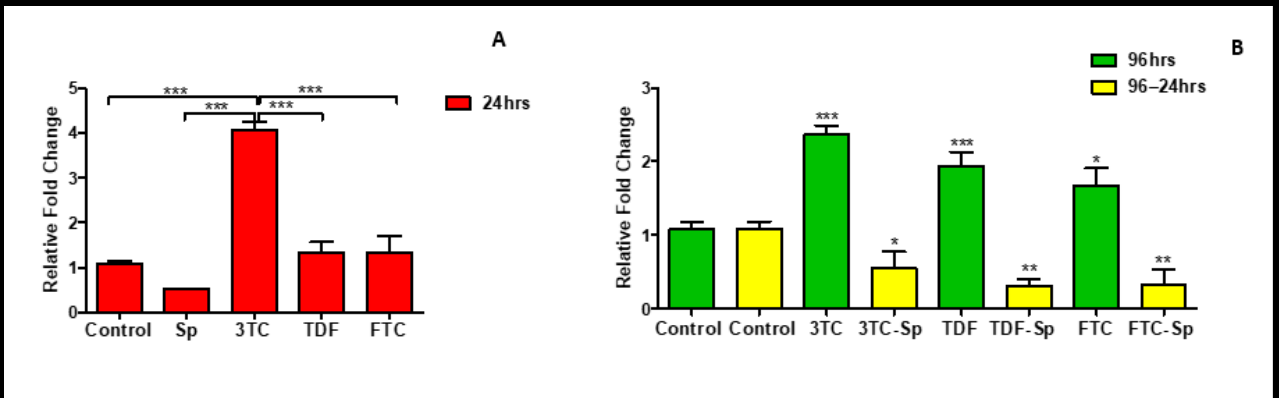
Figure 2. Effects of SP and HAART (3TC, TDF, and FTC) on eNOS mRNA levels. eNOS mRNA levels after exposure of HepG2 cells to ( A ): SP and HAART for 24 h, ( B ): HAART (96 h), and HAART (96 h) followed by SP (24 h); * p < 0.05, ** p < 0.005, *** p < 0.0001 .